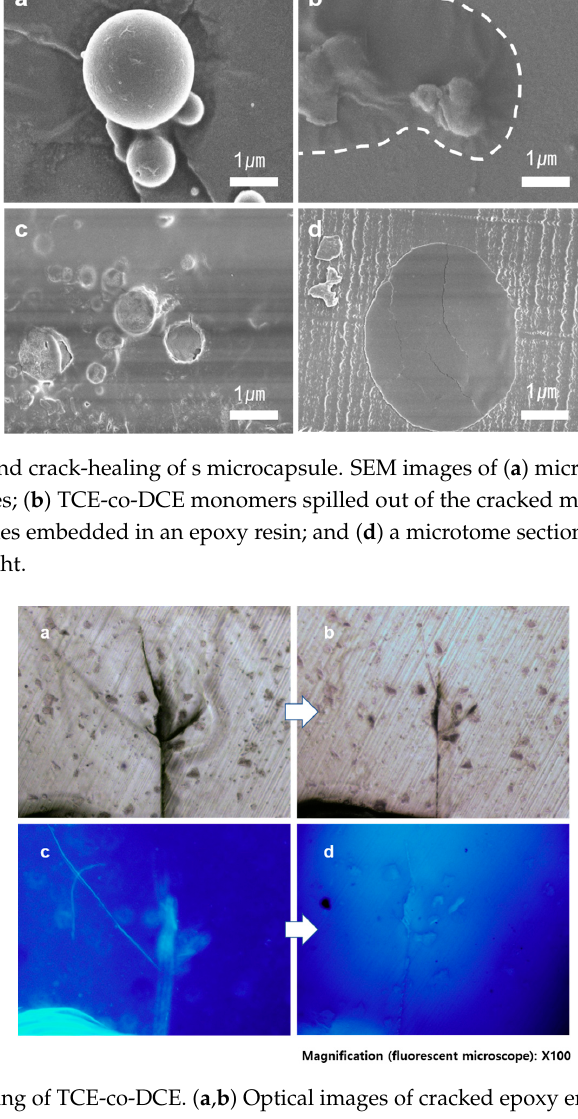
Figure 3. Cracking and crack-healing of s microcapsule. SEM images of ( a ) micro-sized core-shell-like TCE-co-DCE capsules; ( b ) TCE-co-DCE monomers spilled out of the cracked microcapsules on to the floor; ( c ) microcapsules embedded in an epoxy resin; and ( d ) a microtome sectioned area after cracking and irradiation of light.